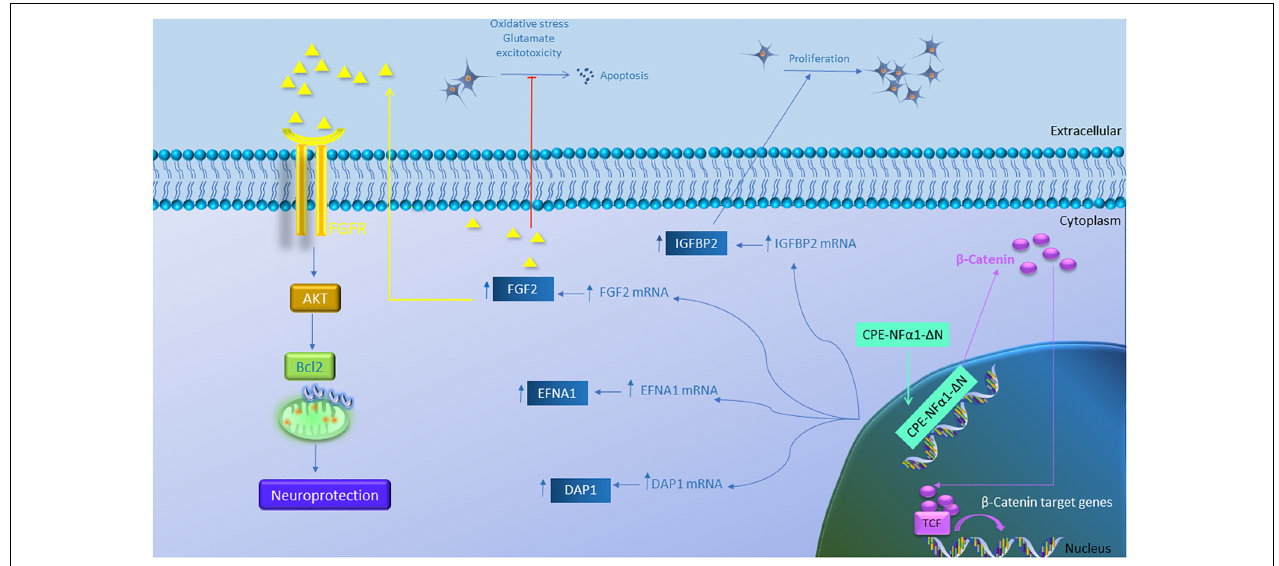
FIGURE 5 | Gene regulation function of CPE-NF α 1- (cid:49) N in mouse embryonic neurons. CPE-NF α 1- (cid:49) N increases expression of FGF2, IGFBP2, EFNA1, and DAP1 in mouse embryonic cortical and hippocampal neurons. IGFBP2 promotes neuronal proliferation while FGF2 inhibits oxidative stress or glutamate-induced excitotoxicity. FGF2 binds its receptor and induces neuroprotective effects via activating the AKT and Bcl2 signaling cascade. CPE-NF α 1- (cid:49) N expressed in hippocampal neurons translocates into the nucleus and upregulates β -catenin expression. β -catenin then enters the nucleus and binds to T-cell factor (TCF) transcription factor to promote expression of Wnt target